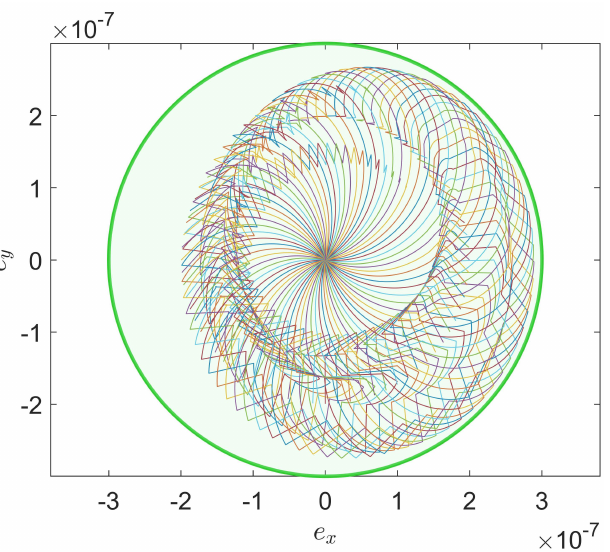
Figure 13. After taking 6 times eccentricity control when B = − 5 × 10 − 11 m/s 2 , 72 curves of f ( e x , e y ) perturbed by solar radiation pressure for l s initial eccentricity vector point ( e x radius r = 3 × 10 − 7